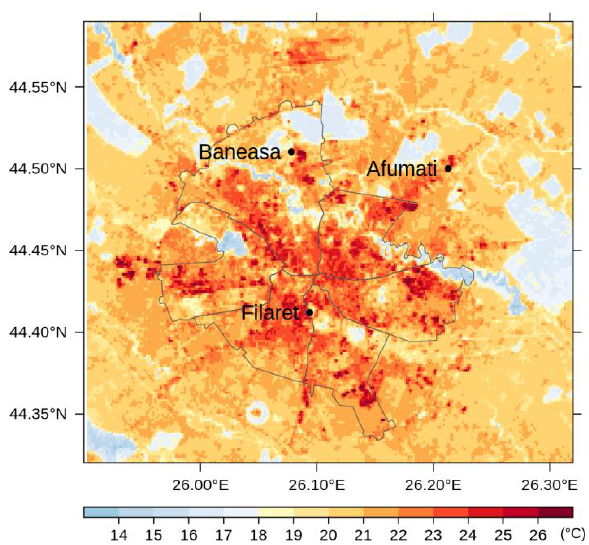
Figure 11. Multi-annual average LST over Bucharest during the warm season (April–September) retrieved from Landsat 8 imagery (2013–2018).